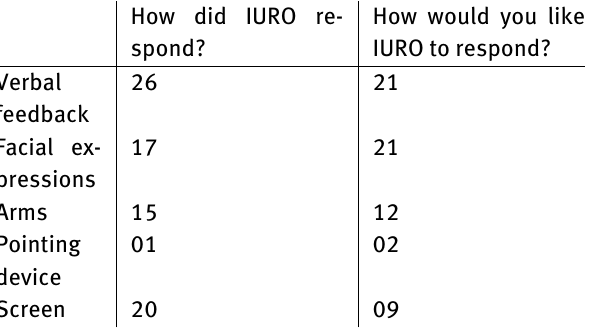
Table 6: How IURO responded and how the participants would like it to respond (n=30) How did IURO